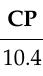
Table 2. Dietary nutrient levels (dry-matter basis, %).